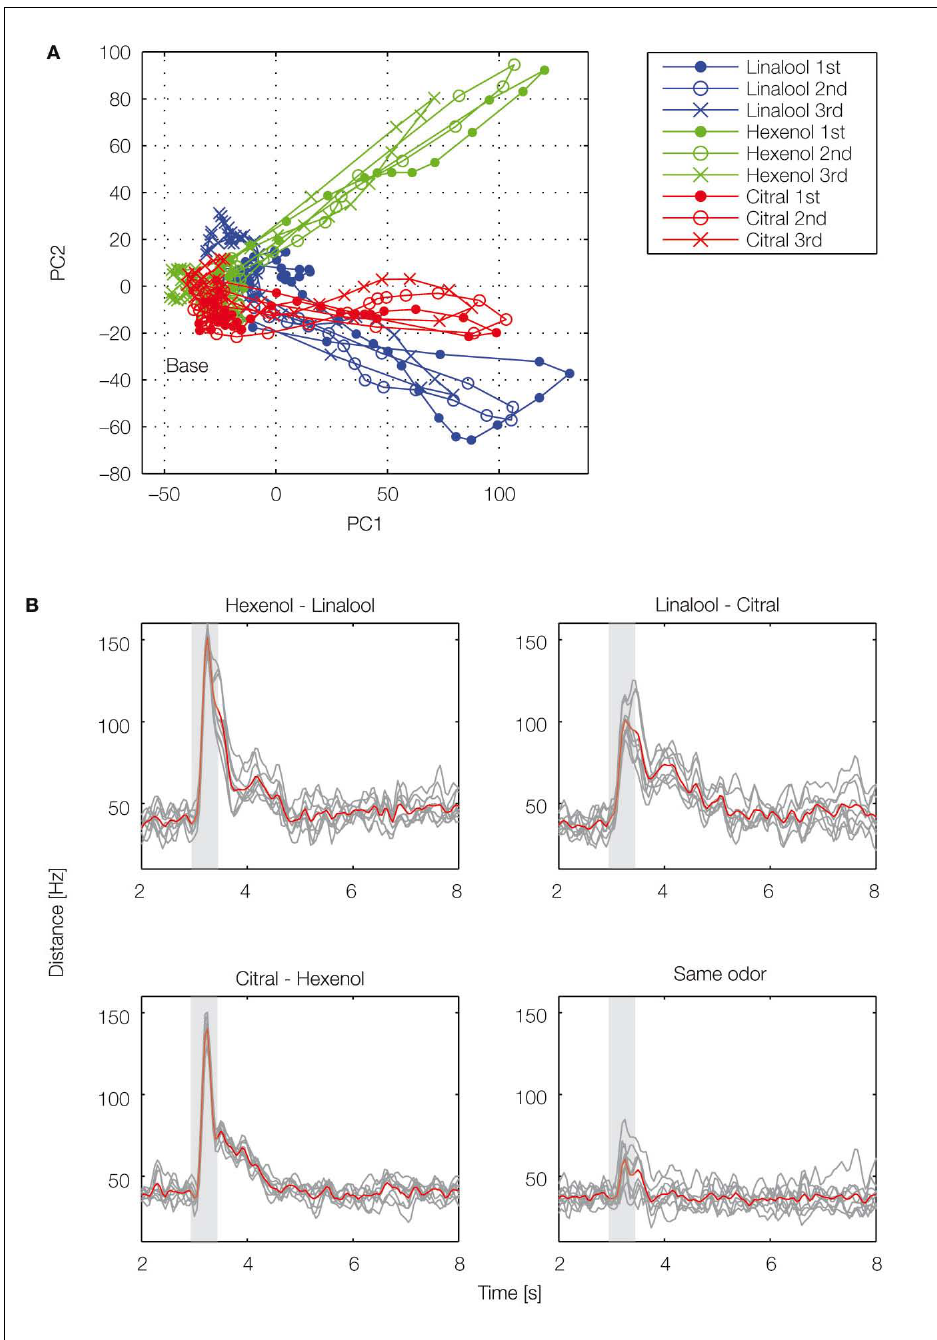
Figure 2 | Temporal evolution of olfactory representations. By applying dimensionality reduction techniques, odor-evoked activities among projection neuron (PN) population are mapped into a 2D space (A) . Illustration of the trajectories representing PN population activity over time in response to cis -3-hexen-1-ol (green), linalool (blue), and citral (red). For each odor, 47 PN spike sequences were divided into consecutive 50-ms time bins and the number of spikes in each bin was counted. We viewed the 47-dimensional vector as the odor representation by the PN population. To visualize the 47-dimensional vector, we applied principal component analysis to the vector and used the fi rst two principal components for the graph. Each representation evolved in an odor-specifi c manner. (B) Each odor is tested three times. Euclidean distances are calculated for each odor pair. Gray lines represent individual trials and the red line represents the average. Gray box shows odor presentation period (500 ms). PC, principal